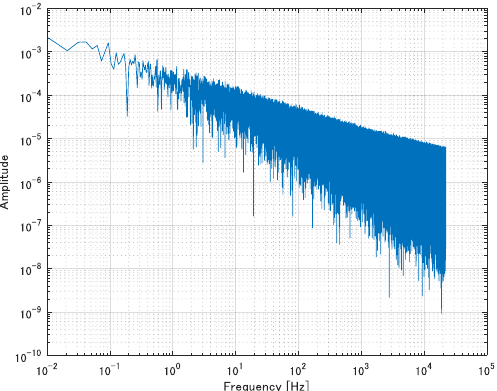
/ f fluctuation Figure 4. Sample of 1/ f fluctuation analysis. Figure 4. Sample of 1